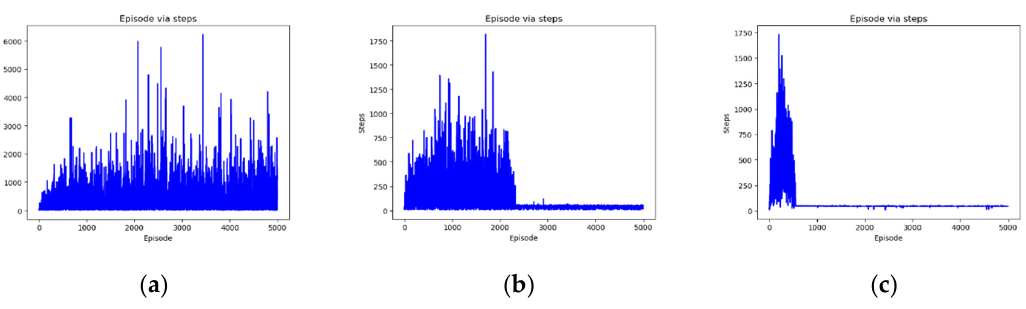
Figure 6. Graph of step changes during training. ( a ) Steps of SARSA algorithm; ( b ) Steps of Q-learn- ing algorithm; ( c ) Steps of the proposed Q-learning optimization algorithm.